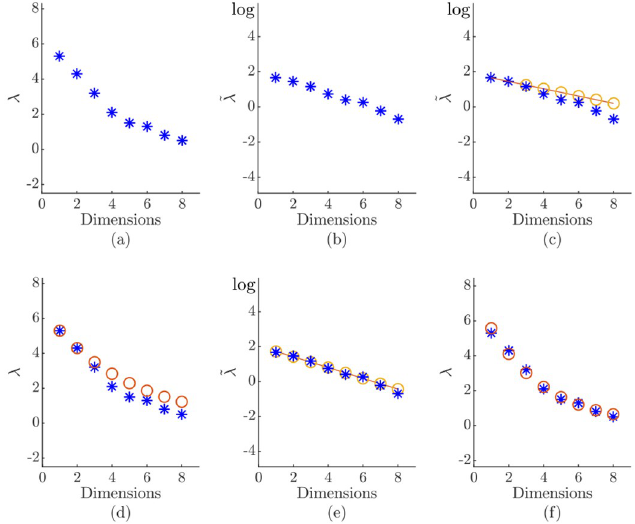
Fig 3. Application of the algorithm to an eight-dimensional Gaussian artificial data set. The real eigenvalues are represented by a star and the estimations by circles: (a-d) 1st step with m = 2; (e-f) 2nd step with m = 4.